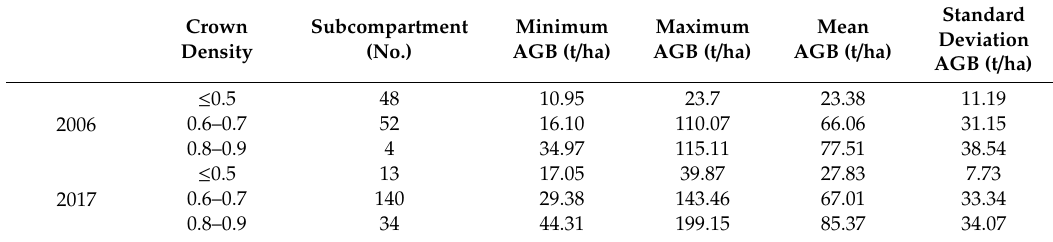
Table 2. Basic information of the field survey data in 2006 and 2017.